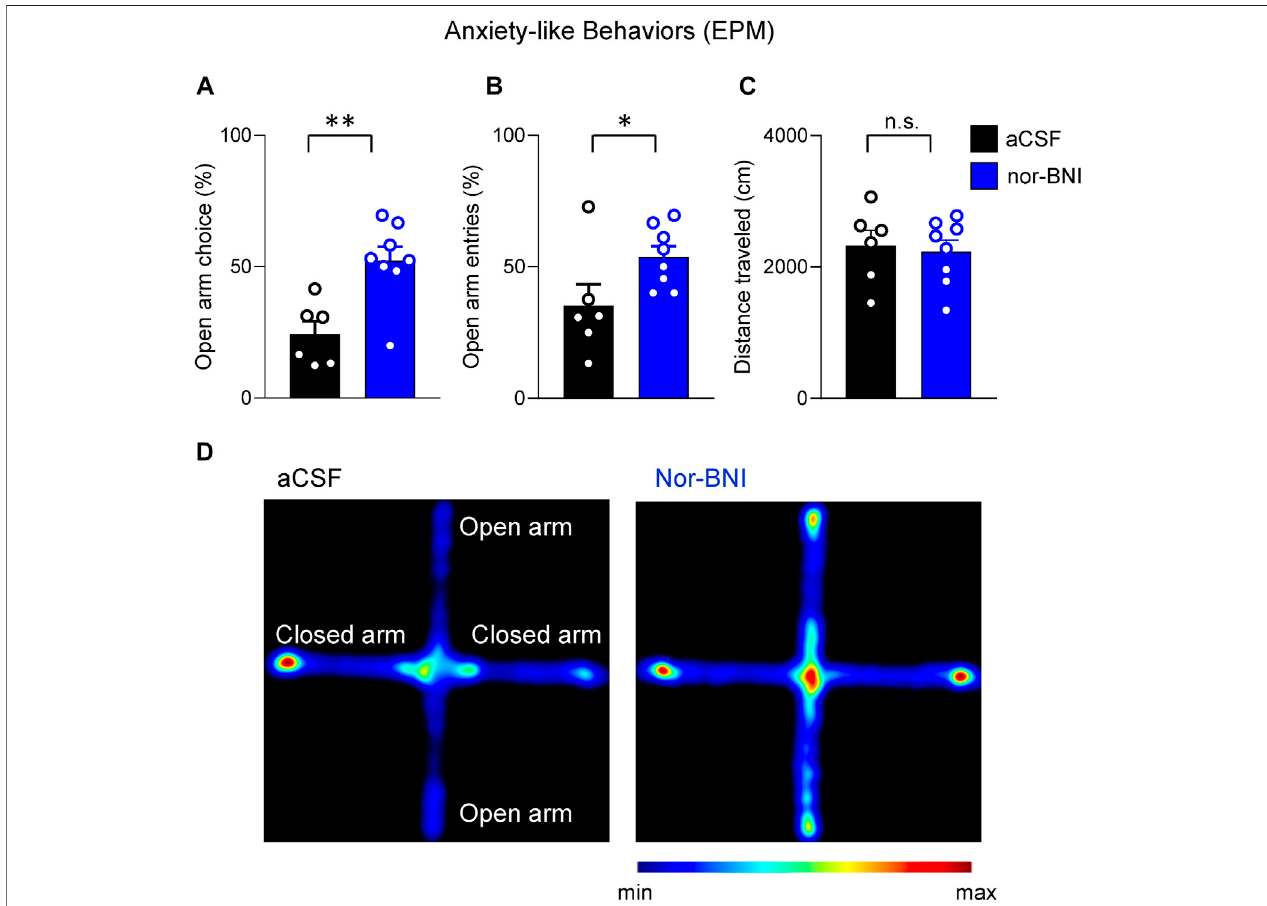
FIGURE4| Inhibitoryeffectsofintra-CeAKORantagonist(nor-BNI)onanxiety-likebehaviorsinafunctionalpainmodel.Intra-CeAnor-BNI(100 μ Minmicrodialysis probe) increased percentage of time in open arms (A) and frequency (percent of total number) of entries into open arms (B) of the elevated plus maze (EPM), indicating anxiety-like behaviors. *, ** p < 0.05, 0.01, t -tests, compared to aCSF control, n = 6 (aCSF), n = 8 (nor-BNI). Total distance travelled was not different between control (aCSF) and treatment (nor-BNI) groups (C) (n.s., p > 0.05, t -test, n = 6 (aCSF), n = 8 (nor-BNI). Bar histograms show means ± SEM. Symbols represent values of individual rats. (D) Representative heat maps show time spent in the closed and open arms of the EPM. A rat pretreated with aCSF into the CeA spent more time in the closed arm (left panel), whereas a nor-BNI pretreated rat spent equal time in the closed and open arms (right panel).